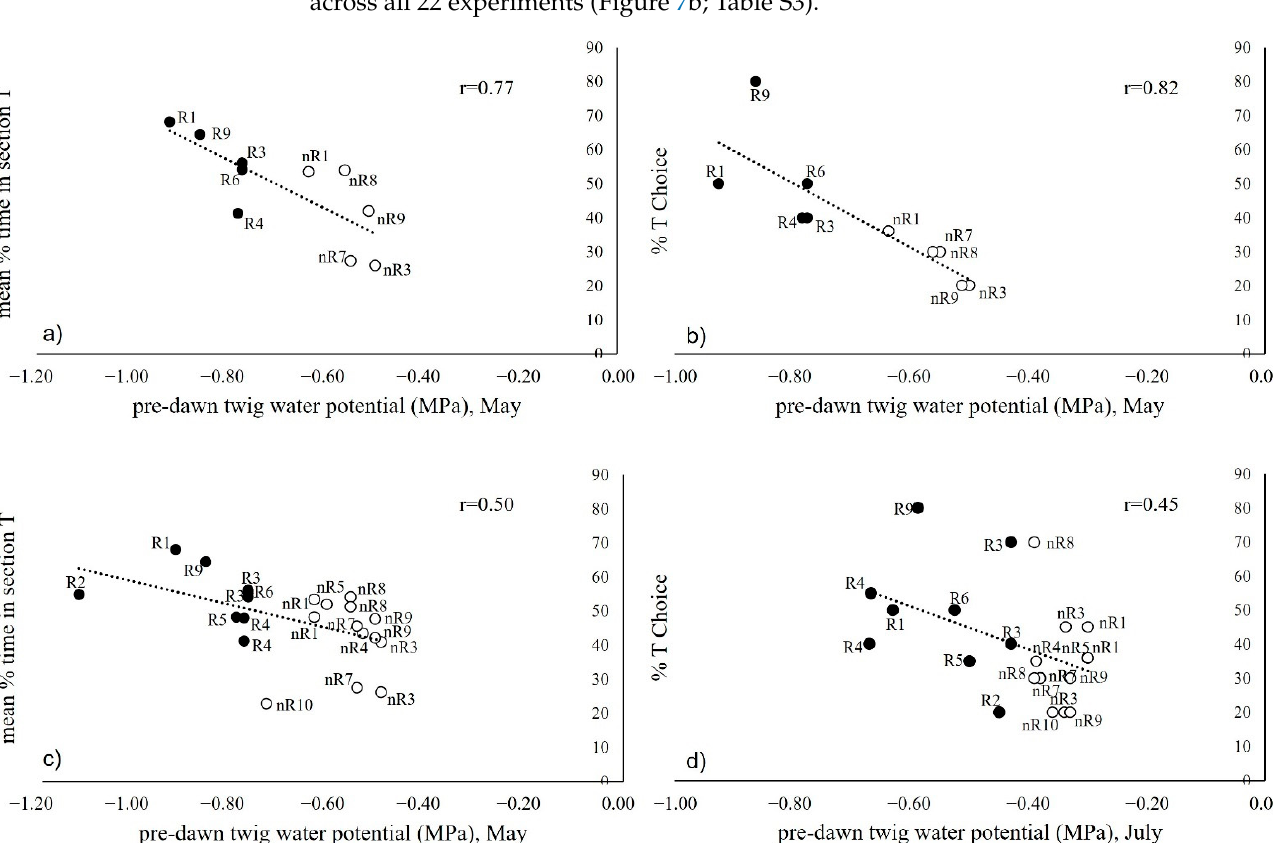
Figure 6. Linear relationships (indicated by dotted regression lines) of pre-dawn twig water potential measured in May 2020 and ( a ) mean relative time (mean % time) spent by male Ips typographus test beetles in section T (Pearson correlation r = 0.77; n = 10; p = 0.009), ( b ) proportion of T choices (% T choice) for all “T and C1” experiments (r = 0.82; n = 10; p = 0.003); ( c ) mean relative time (mean % time) spent by test beetles in section T for all “T and C” experiments (r = 0.50; n = 22; p = 0.019). Linear relationships (indicated by dotted regression lines) of pre-dawn twig water potential measured in July 2020 and ( d ) proportion of T choices (% T choice) for all “T and C” experiments. nR trees: white circles, R trees: black circles; study trees tested against both controls, C1 and C2, are represented twice in ( c , d ).